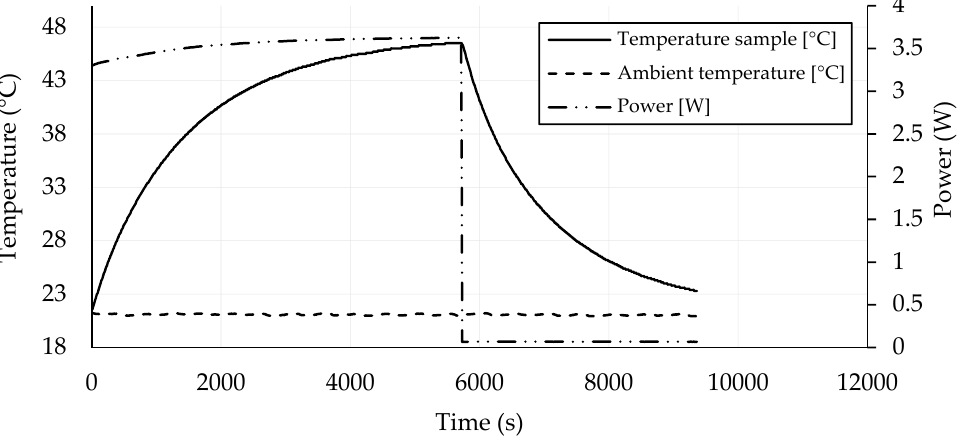
Figure 13. Self-heating experiment—CB 2.25, 40 V.